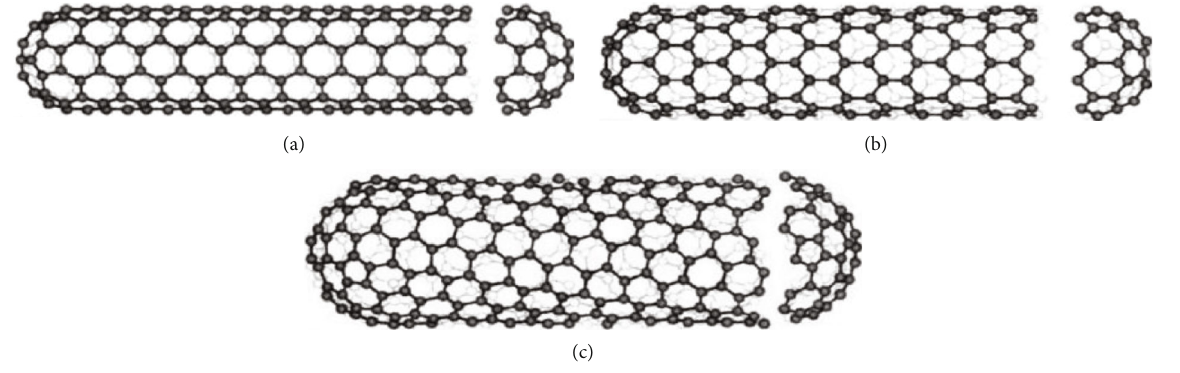
Figure 2: Di ff erent chiralities of CNTs. 1 armchair, 2 zig-zag, 3 chiral